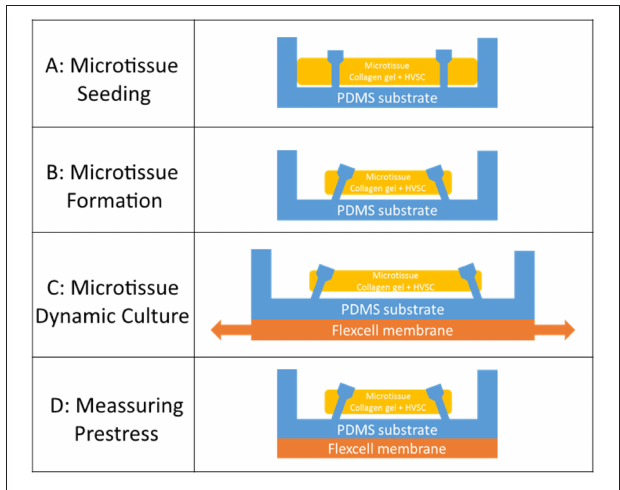
FIGURE 2 | (A) Seeding of the cell/gel suspension in a microwell. (B) Formation of a microtissue. (C) Dynamic stretching of a microtissue. (D) Measuring prestress by tracking the micropost